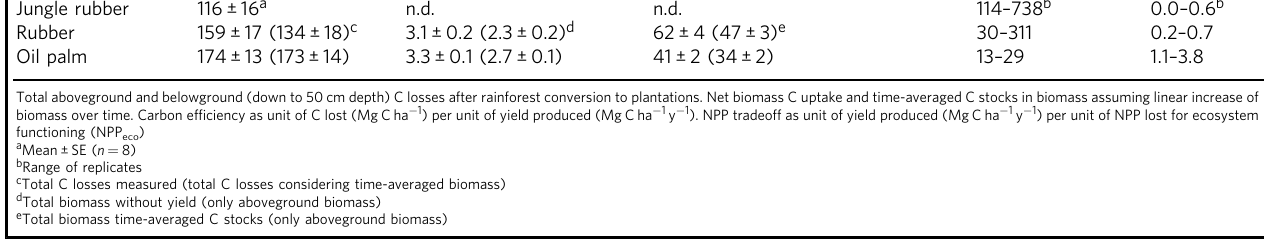
Table 1 Gain and cost of land-use change Land uses